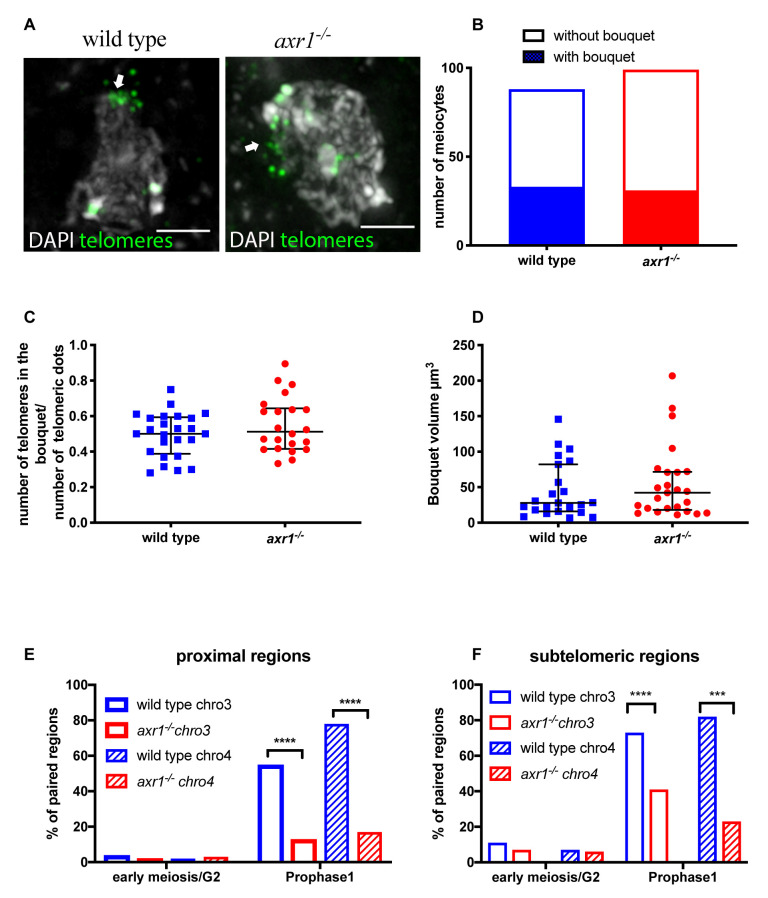
Dynamic of chromosomes during meiosis prohase: telomeres localization and pairing.A: FISH on intact wild type and axr1-/- meiocytes with the telomeric probe pTat4. The pictures correspond to projections of z-sections obtained by epifluorescence microscopy followed by deconvolution. In Prophase I telomeres cluster to one side of the nucleus (white arrow). Scale bar 2μm B: Quantification of the proportion of meiocytes displaying a telomere bouquet. (wild type n = 107; axr1-/- n = 102) C: Quantification of the proportion of telomeres included in the bouquet (wild type n = 24; axr1-/- n = 22). D: Bouquet volume in μm3. The volume was calculated as described in the Material and Methods. (wild type n = 23, axr1-/- n = 25). Wild type (wt) = Col-0; Red circles axr1-/- = SAIL_904_E06. Black bars represent the median with the interquartile range. E: Quantification of the pairing of proximal regions of chromosome 3 (empty rectangles) and chromosome 4 (striped rectangles) in early meiosis/G2 and Prophase I (wild type (blue)) chromosome 3 early/G2 n = 46 prophase I n = 175; chromosome 4 early/G2 n = 46 prophase I n = 138; axr1-/- (red) chromosome 3 early/G2 n = 53 prophase I n = 53; chromosome 4 early/G2 n = 53 prophase I n = 53).(Prophase I, chromosome 3 chi-square test, two-sided, p-value = 3.7 10−8; chromosome 4 chi-square test, two-sided, p-value<10–10) F: Quantification of the pairing of subtelomeric regions of chromosome 3 (empty rectangles) and chromosome 4 (striped rectangles) in early meiosis/G2 and Prophase I. Wild type chromosome (blue): early/G2 n = 47 prophase I n = 132; chromosome 4 early/G2 n = 29 prophase I n = 111. axr1-/- (red) chromosome 3: early/G2 n = 43 prophase I n = 51; chromosome 4 early/G2 n = 35 prophase I n = 43.(Prophase I, chromosome 3 chi-square test, two-sided, p-value = 6.7 10−5; chromosome 4 chi-square test, two-sided, p-value = 2.9 10−4). Wild type (wt) = Col-0; axr1-/- = SAIL_904_E06.